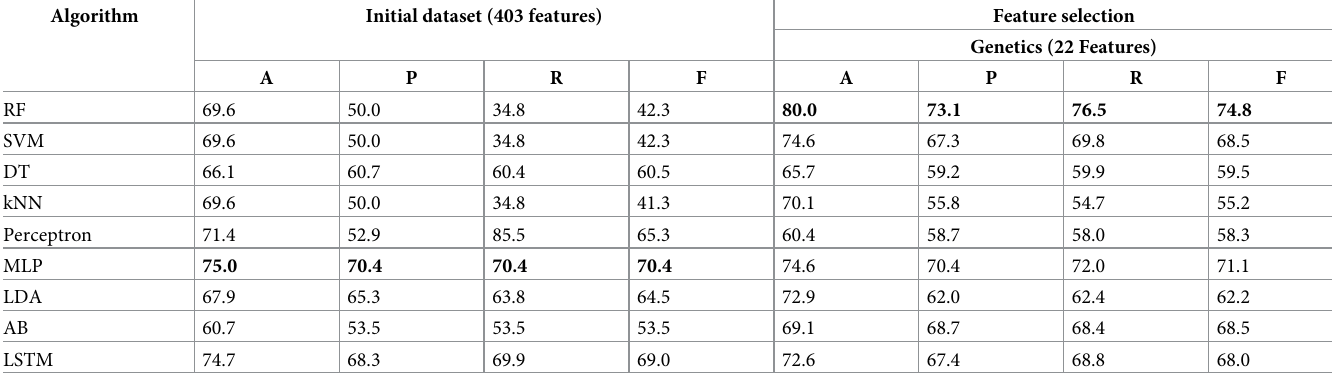
Table 4. Comparison of the performance of the algorithms on the initial dataset and the one with features selection (no. class = 2). Algorithm